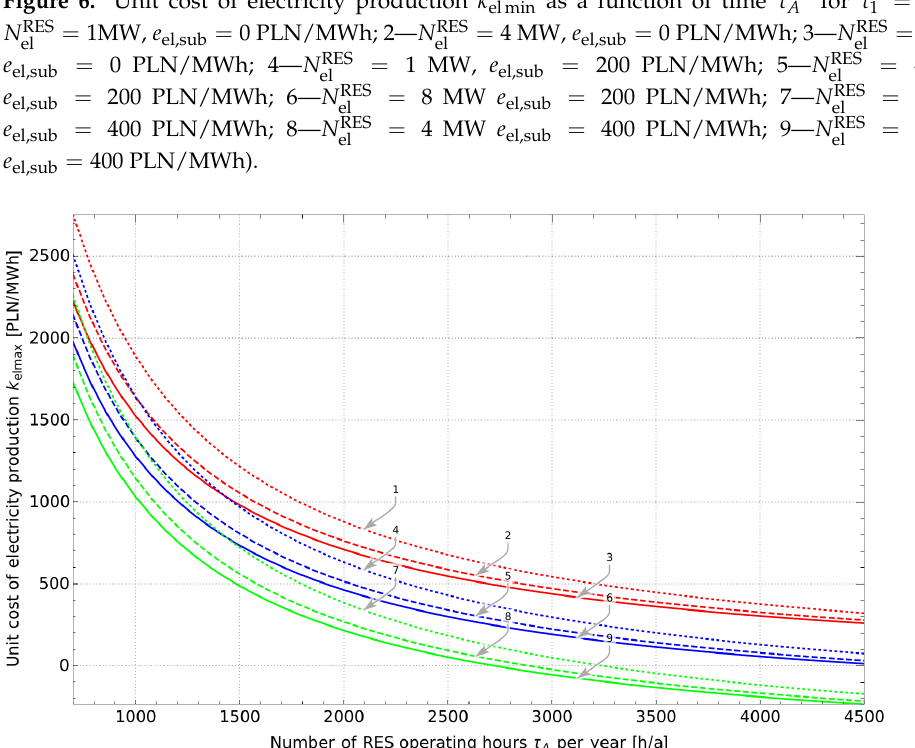
Figure 7. Unit cost of electricity production k elmax as a function of time τ A for τ 1 = τ 1max